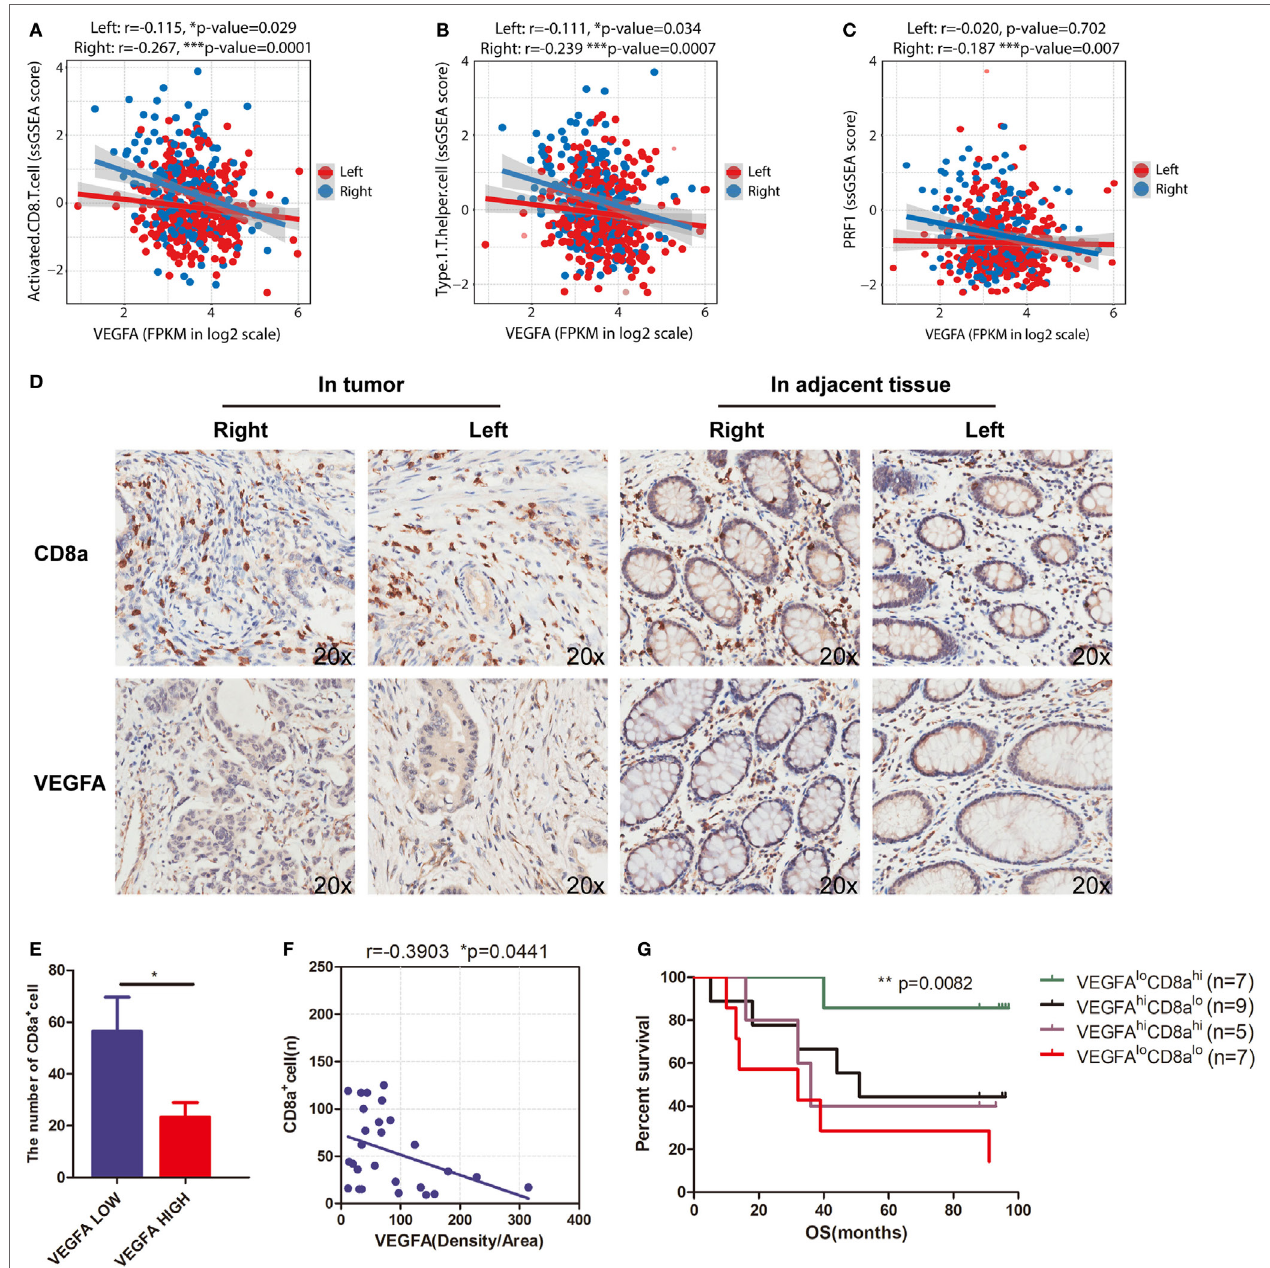
FigUre 4 | VEGFA hinders T-cell infiltration in right-side colorectal cancer (CRC). Correlations between (a) VEGFA and T-cell infiltration (right side: r = − 0.267, p = 0.0001; left side: r = − 0.115, p = 0.029), (B) VEGFA and Th1-cells (right side: r = − 0.239, p = 0.0007; left side: r = − 0.111, p = 0.034), and (c) VEGFA and perforin (PRF1) expression (right side: r = − 0.187, p = 0.007; left side: r = − 0.02, p = 0.702). (D) Infiltration of CD8 cells and expression of VEGFA detected in CRC tissue microarrays (20 × ). (e) The number of CD8 alpha-positive cells in the VEGFA low and high group in right-side tumors. The group was divided into two subgroups based on the median value (* p = 0.0386). (F) Correlation between VEGFA and CD8 alpha-positive cells in right-side tumors ( r value represents Pearson correlation coefficient). Two-tailed p -values are presented for significance ( < 0.05; r = − 0.3903, p = 0.0441; n = 28). (g) Kaplan–Meier curves for cancer-specific survival based on CRC immune infiltration classes. The CD8 hi VEGFA lo class had the best survival, whereas other classes were associated with poor outcome (log-rank test, p = 0.0082). Two-tailed Student’s t -tests and Kaplan–Meier survival log-rank test were used for those analyses. Error bars represent the mean ± SEM. * p < 0.05; ** p < 0.01; *** p < 0.001; p ≥ 0.05, not